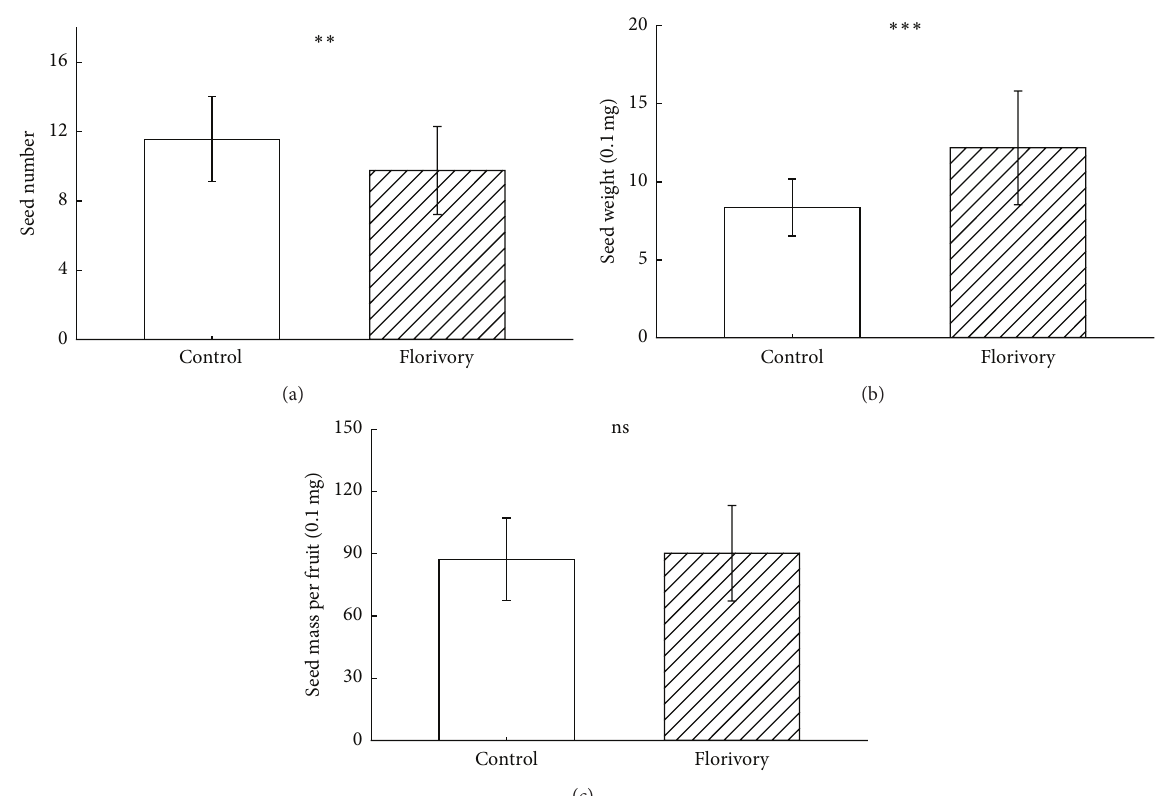
Figure 2: Effects of florivory on the seed number per fruit, the seed weight, and the seed mass per fruit. ∗∗ 𝑃 < 0.01 ; ∗∗∗ 𝑃 < 0.001 ; ns: not